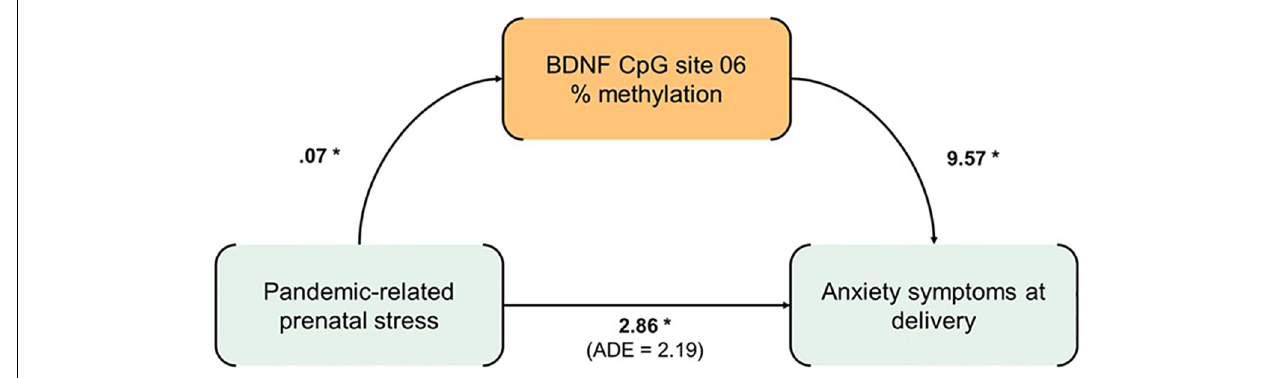
FIGURE 3 | Mediation model. * p <